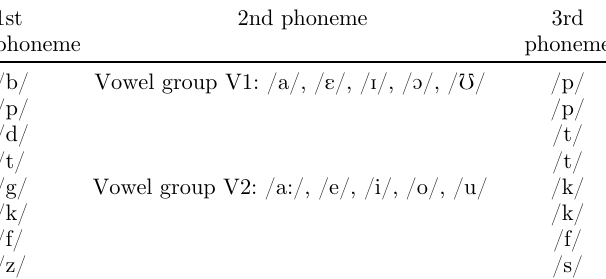
Table 1. CVC set of logatomes. For a given row, ten logatomes are constructed using the pair of the 1st and 3rd phoneme combined with one of the vowels given in the 2nd phoneme column.